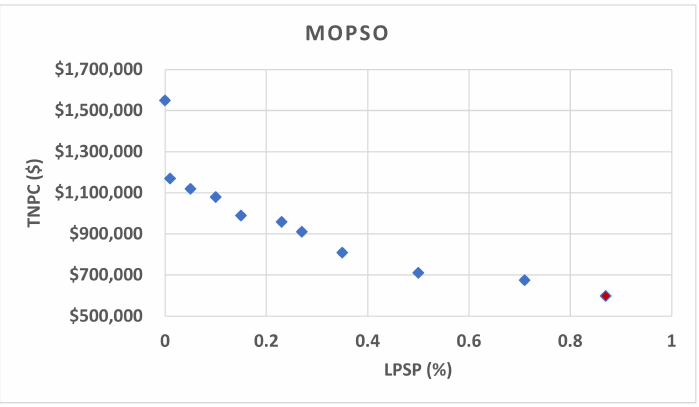
Table 3. Techno-economic characteristics of the system